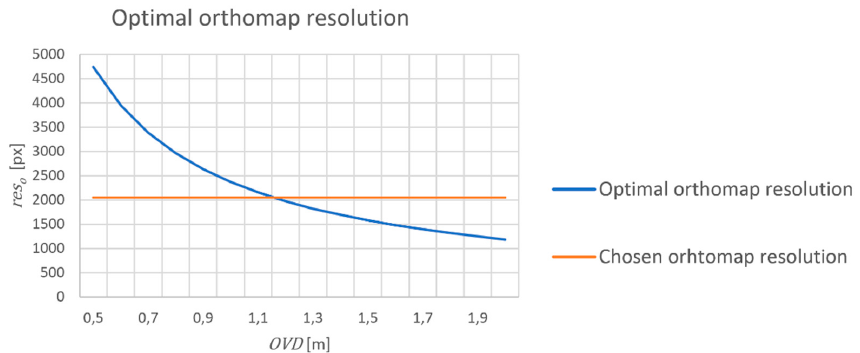
Figure 8. Orthomap resolution res o and OVD: optimal resolution with respect to optimal viewing distance (blue) and closest power of 2 for viewing distance equal to 1 m (orange).